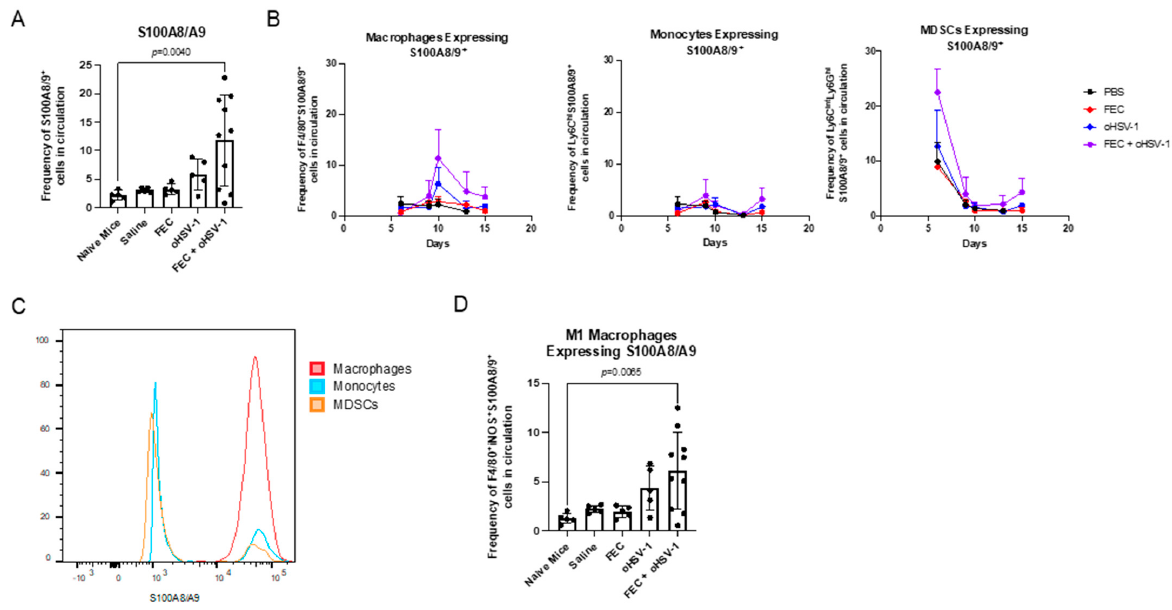
Figure 6. FEC + oHSV-1 therapy increases S100A8A9 in the peripheral blood. C57/Bl6 mice bearing E0771 subcutaneous tumors were treated with either PBS ( n = 5), FEC ( n = 5), oHSV-1 ( n = 5), or FEC + oHSV-1 ( n = 10). Blood was taken 10 days after the start of treatment for analysis via flow cytometry. ( A ) Bar plots showing the frequencies of S100A8/A9 + cells in circulating PBMCs. Dots are representative of individual mice. Error bars are representative of the standard deviation. ANOVA test was used for statistical analysis. ( B ) Line graphs illustrating the mean frequency of macrophages expressing S100A8/A9, monocytes expressing S100A8/A9 and MDSCs expressing S100A8/A9 in the peripheral blood over multiple days. Error bars are representative of standard deviation. ( C ) Representative flow histograms showing the expression of S100A8/A9 on macrophages, monocytes, and MDSCs in the peripheral blood of mice treated with FEC + oHSV-1 therapy. ( D ) Bar plots showing the frequencies of S100A8/A9+ cells in circulating M1-like macrophages. Dots are representative of individual mice. Error bars are representative of the standard deviation. ANOVA test was used for statistical analysis.